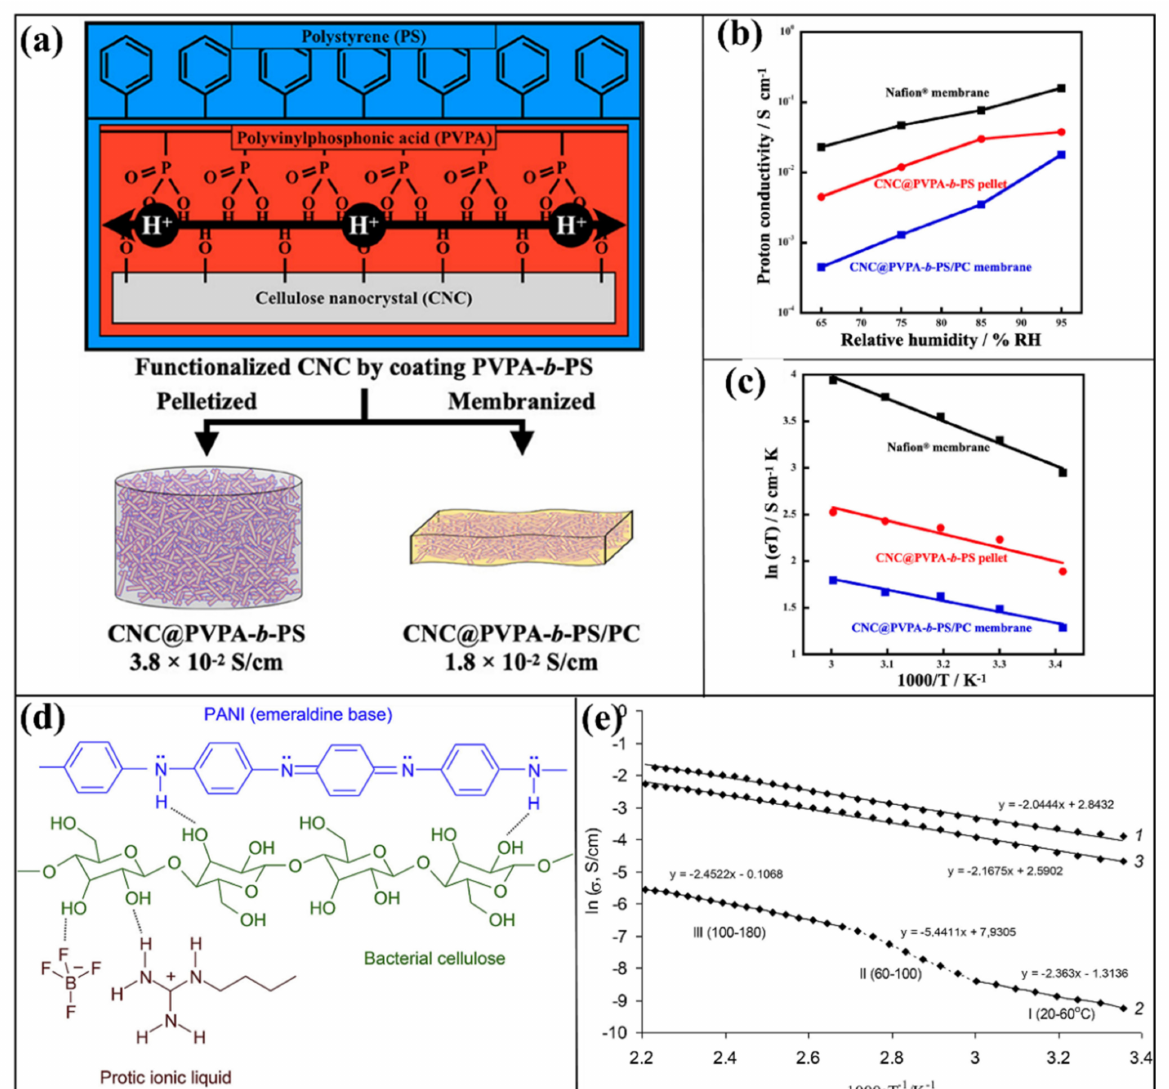
Figure 9. ( a ) Schematic representation of poly(vinylphosphonic acid)–b–polystyrene-coated